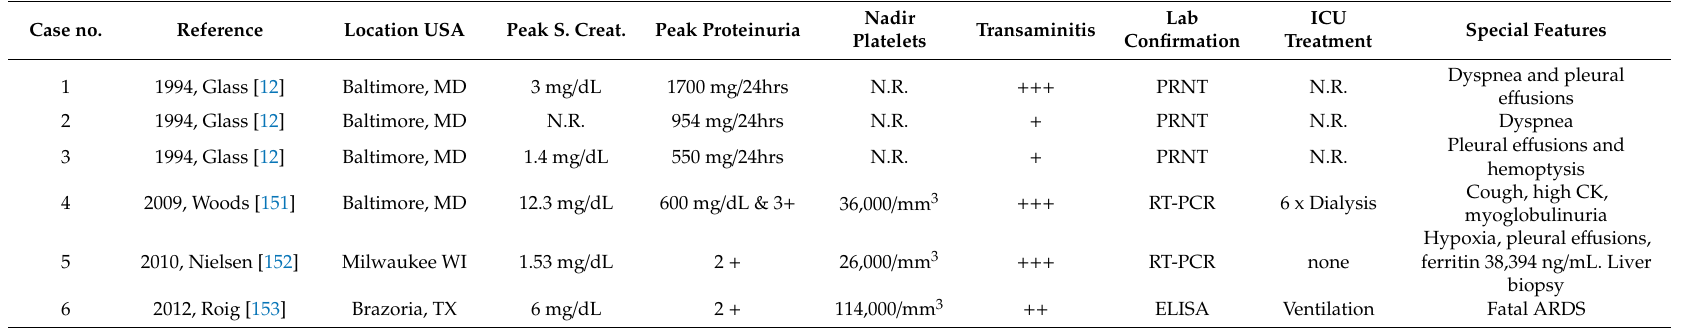
Table 1. Characteristics of six reported (1994–2012) SEOV-HFRS cases in the USA, after reported or supposed exposure to wild rats. Case